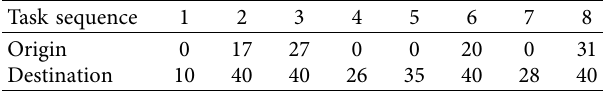
Table 2: Task group example.